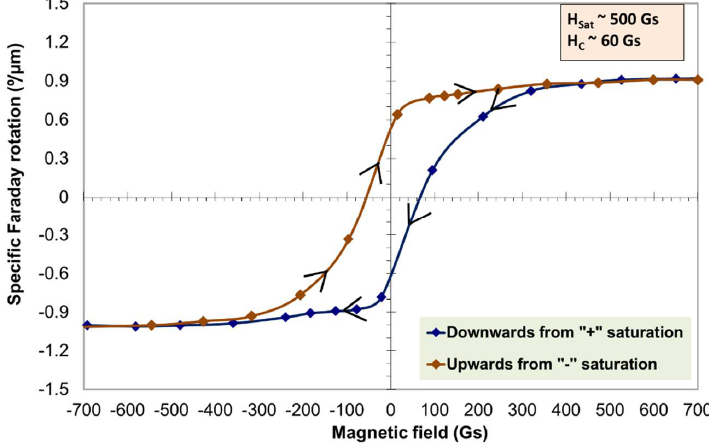
Figure 14. Measured hysteresis loop of Faraday rotation at 532 nm of a 1.272 μm thick annealed garnet sample.